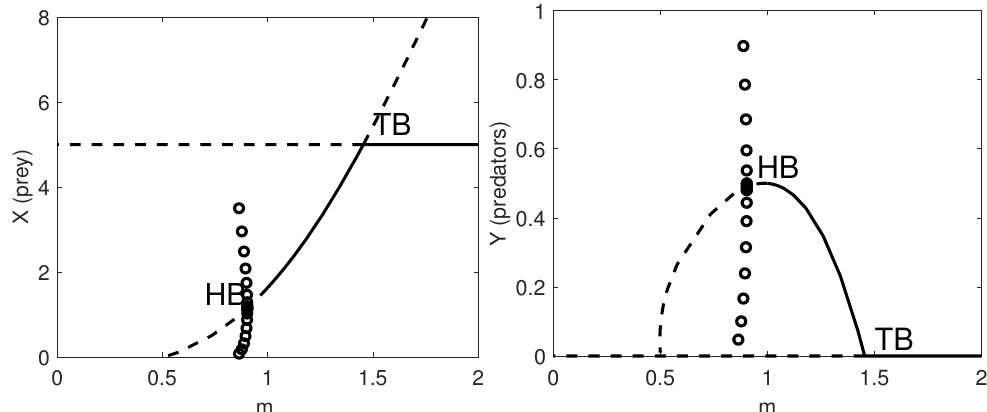
Figure 7. One-parameter bifurcation diagram with respect to m . Left panel : the prey population dynamics. Right panel : the predator population dynamics. Thick lines: stable equilibria; dashed lines: unstable equilibria; HB: supercritical Hopf bifurcation point where a stable limit cycle arises with maximum amplitude given by the amplitude of the HB (circles); TB: transcritical bifurcation point where the coexistence equilibrium exchanges its stability with the prey-only equilibrium. The remaining parameter values are as in Table 9.